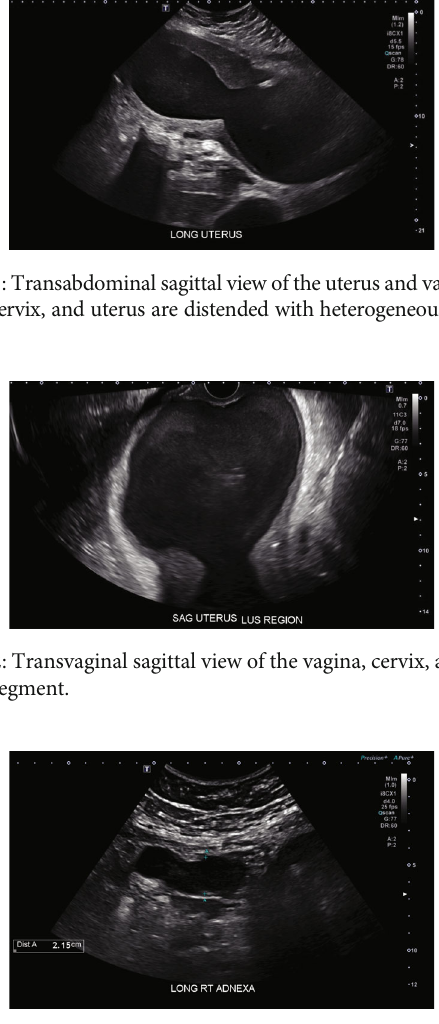
Figure 3: Transabdominal coronal view of the right adnexa showing a hypoechoic structure, suggestive of hydrosalpinx or